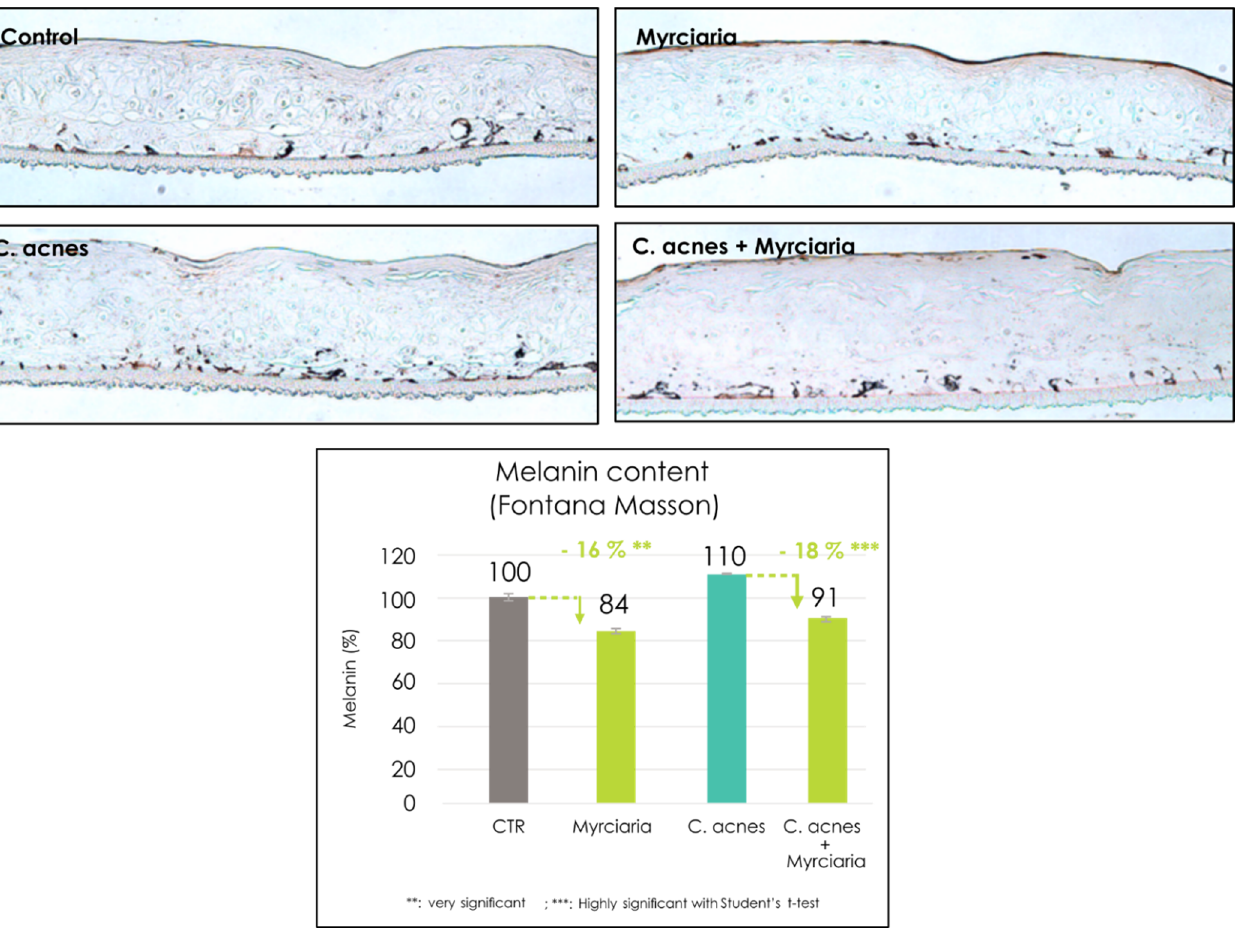
Figure 2. Effect of Myrciaria Dubia fruit extract on hyperpigmentation induced by C. acnes . Melanin was stained by Fontana-Masson staining. RHPE were pretreated with Myrciaria dubia fruit extract once a day for 2 days from Day 10. C. acnes was applied at day 12 for 24 h. Staining was performed on RHPE at day 14 (three pictures per condition were analyzed).